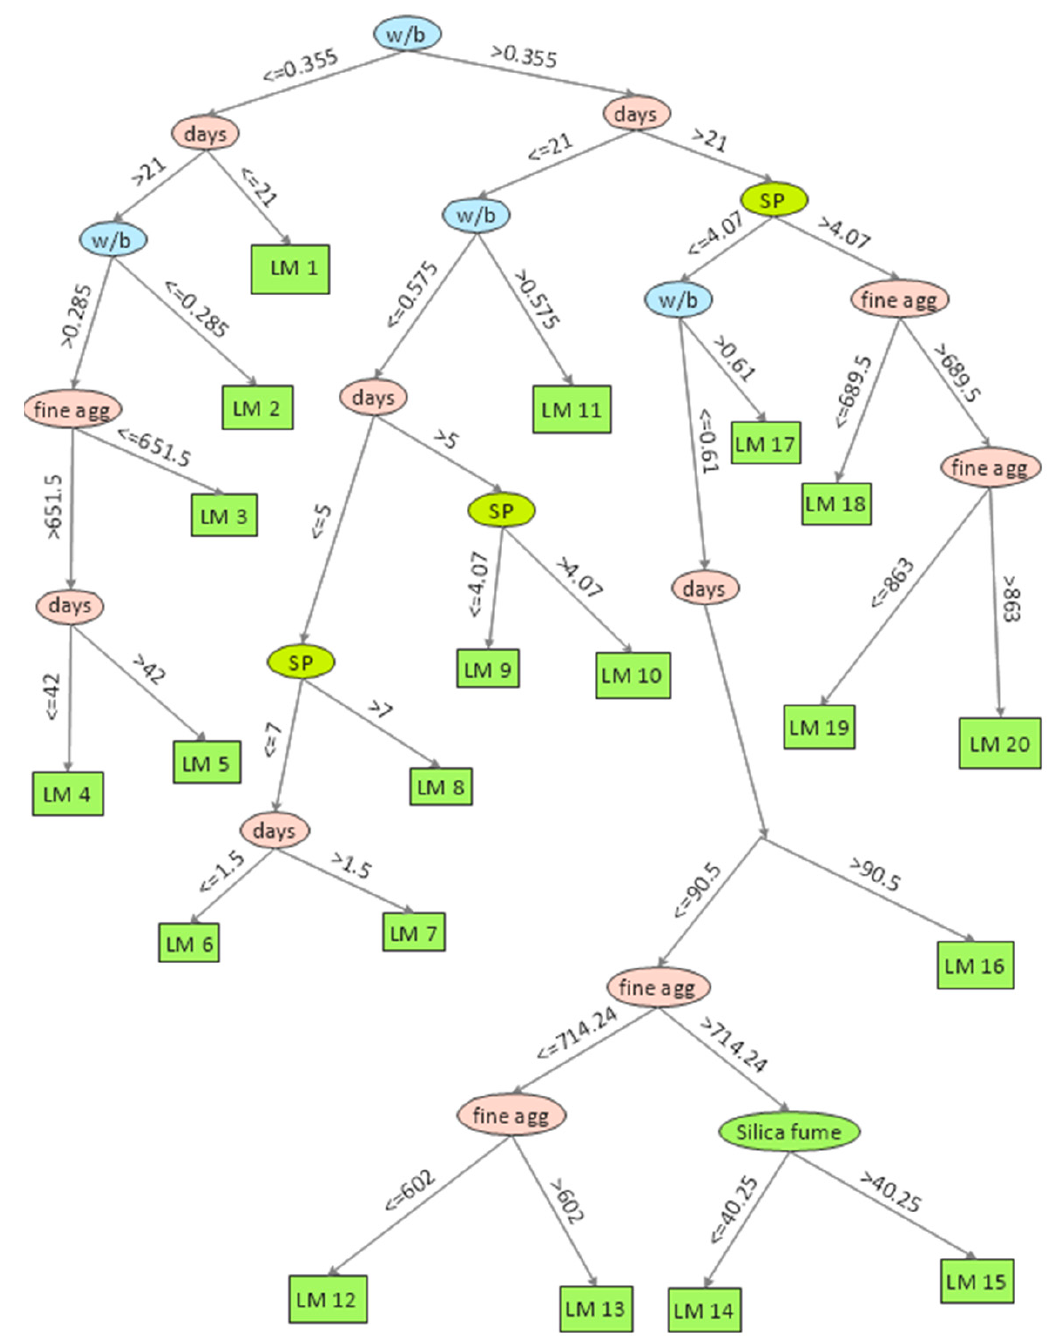
Figure 4. Generated model tree structure of M5P for